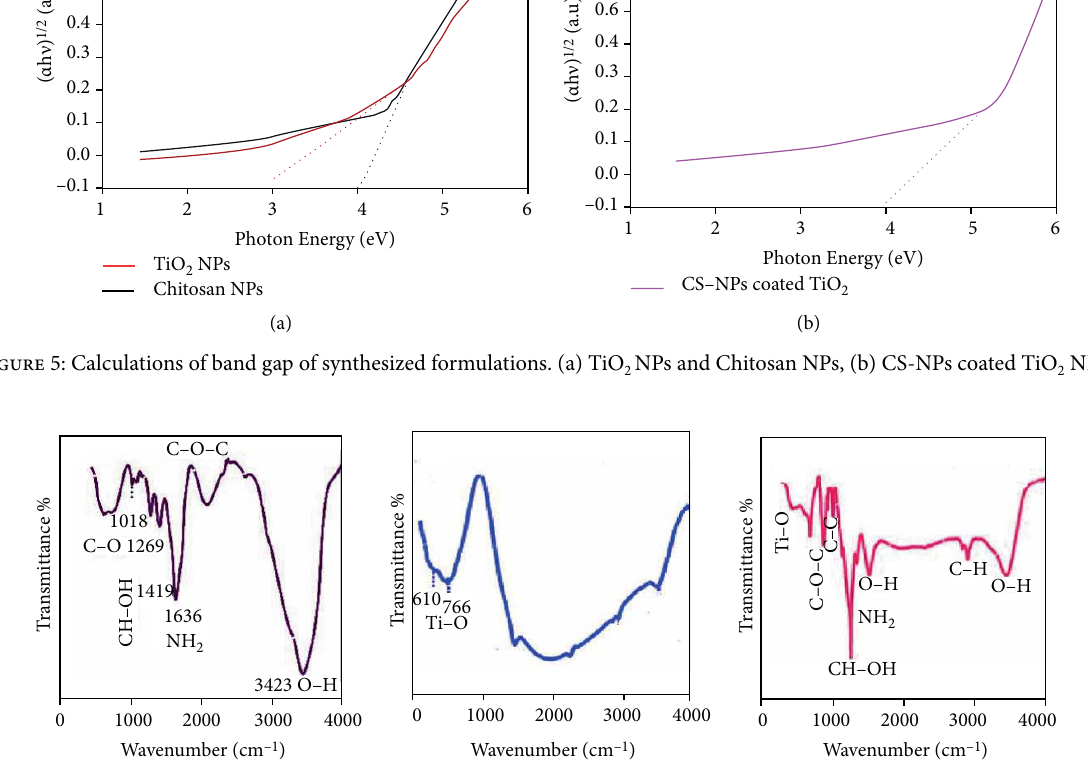
NPs, (c) CS-NPs coated TiO 2